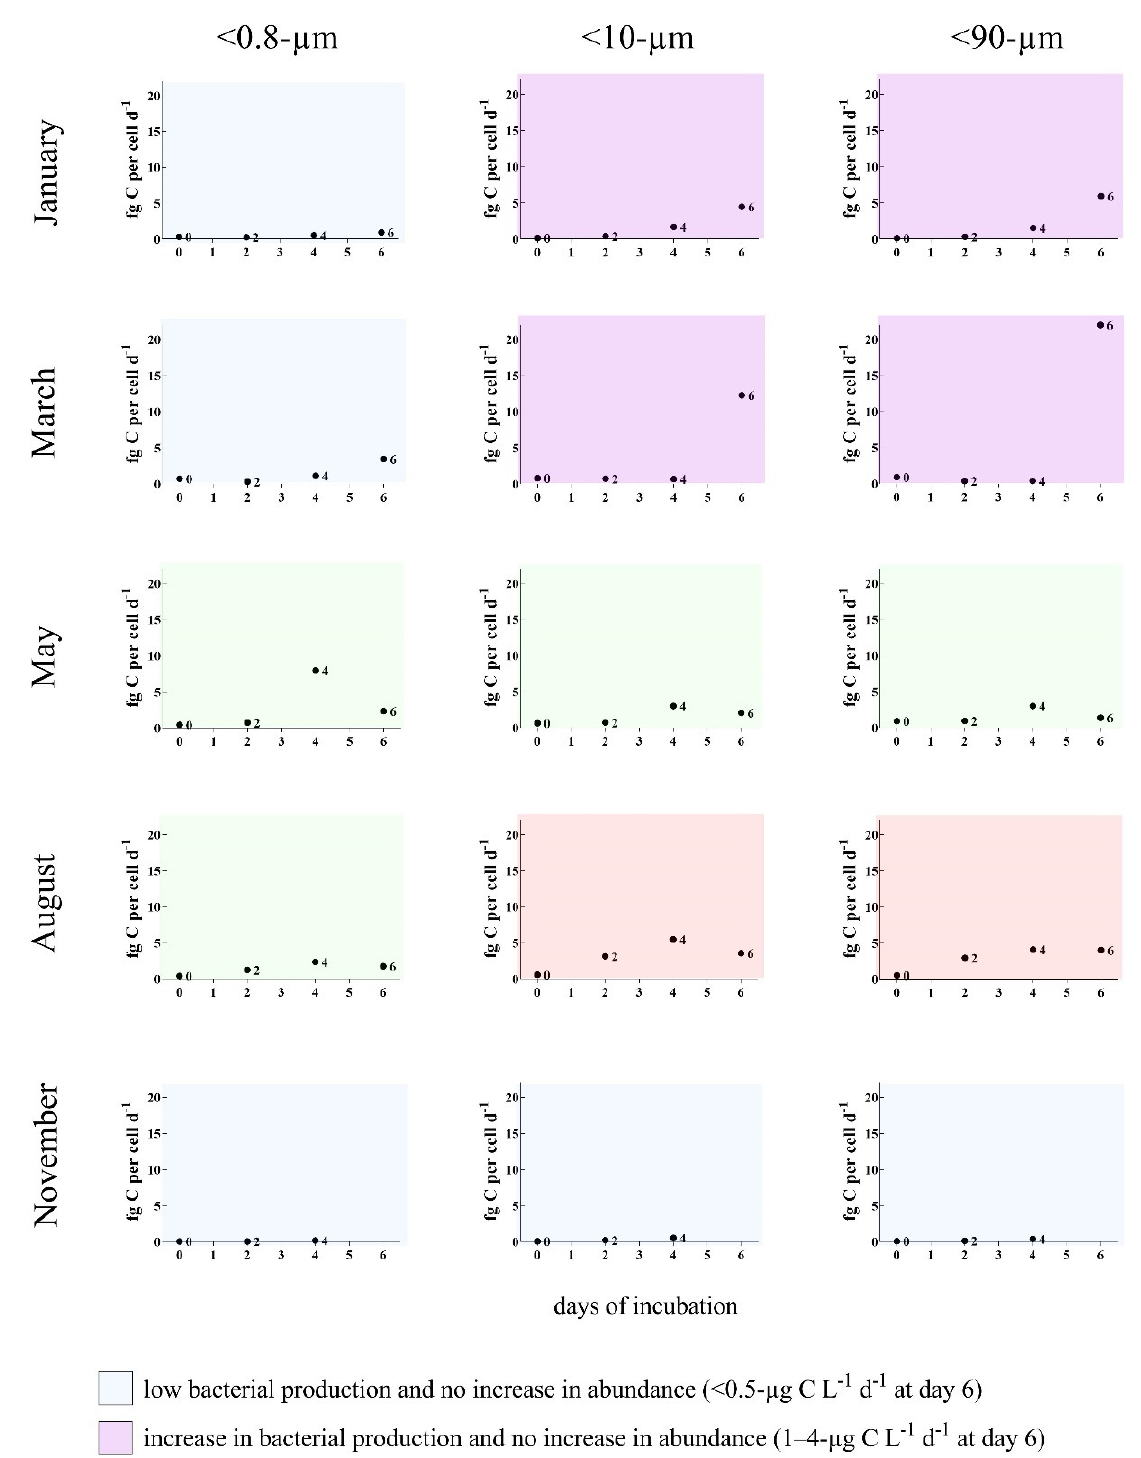
Figure A2. Bacterial production per cell in fg C per cell per day. Colors are based on Figure 3, showing different patterns of bacterial activity.